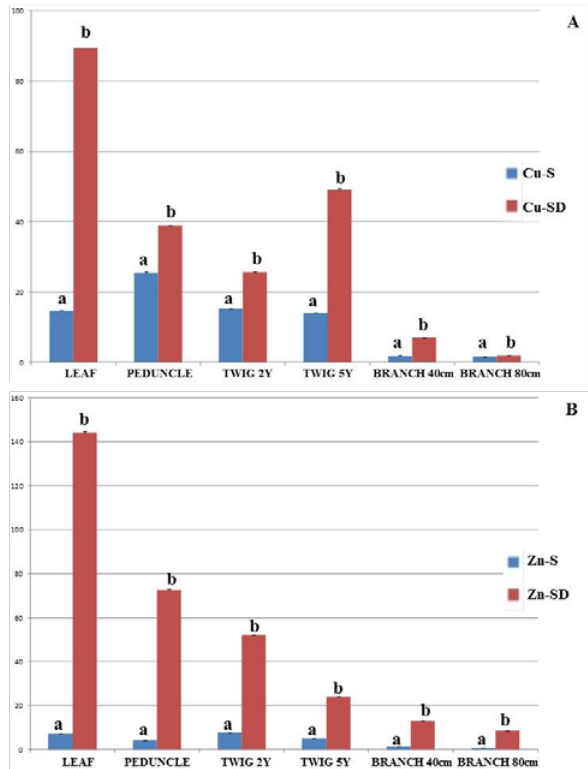
Figure 3. (A) Mean amounts of copper (Cu ++ ) and (B) of zinc (Zn ++ ) (ppm) within olive tree leaves, petioles, fruit pedun- clesor stems of two-year-old twigs, or five-year-old twigs, and branches at 40 cm and at 80 cm from endotherapy in- jection points (see also Figures 1 and 2). Data were obtained using the Inductively Coupled Plasma Atomic Emission Spectroscopy (ICP-AES) technique, and are means± stand- ard deviations. Cu: copper; Zn: zinc; S. safranin-O; SD: safranin-O/Dentamet® mixture. Bars represent standard errors. Different letters indicate statistical significance at P